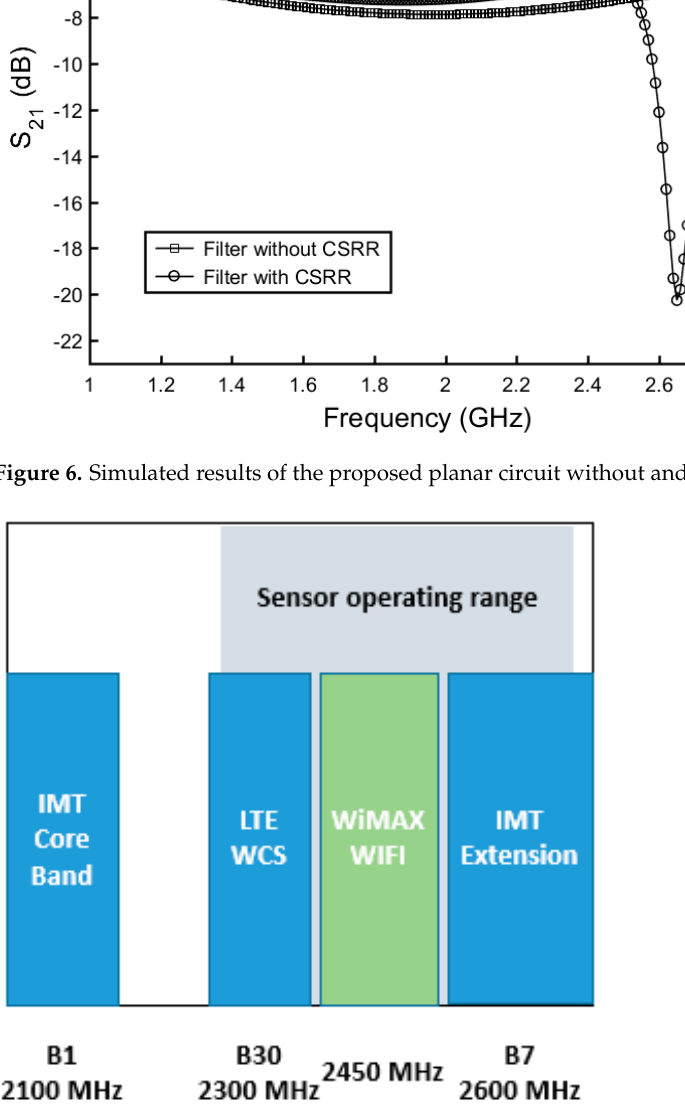
Figure 7. Frequency division LTE bands, compiled from 3GPP 36.101 [25] .